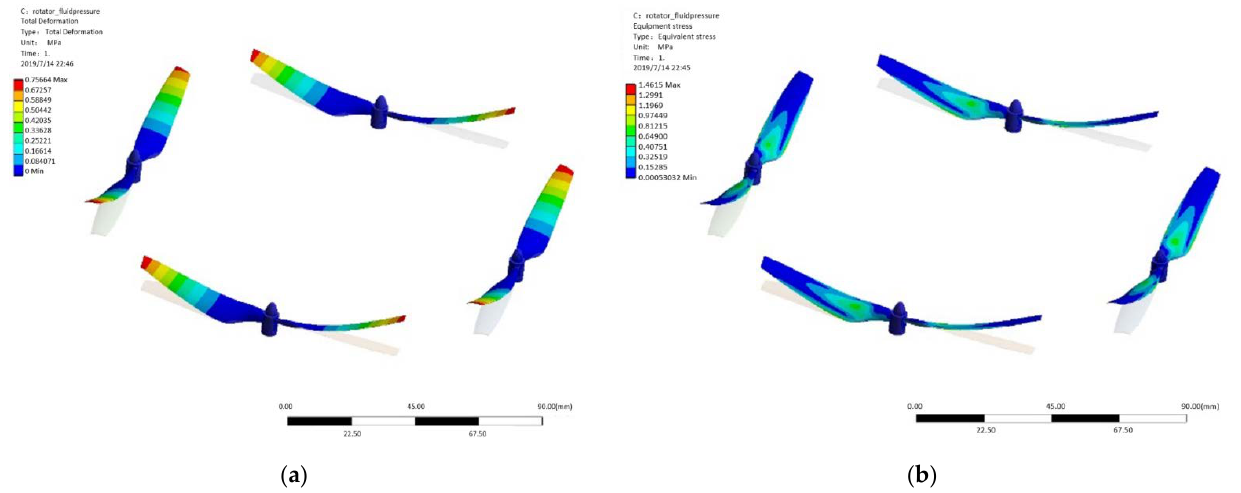
Figure 11. Stress cloud map ( a ) and deformation cloud map ( b ) of rotor under lift and self-weight.